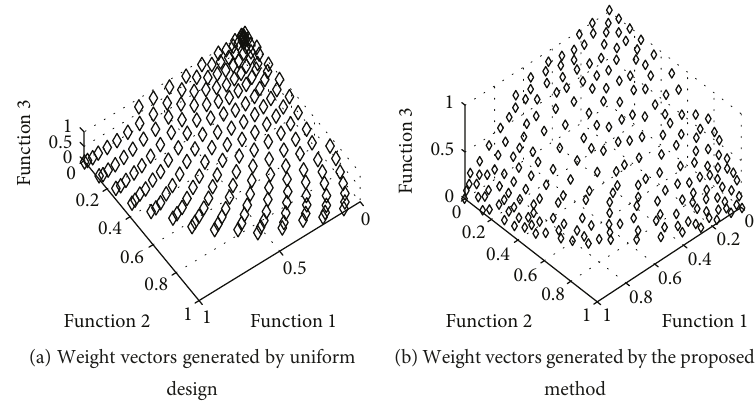
Figure 1: Uniformly distributed weight vectors generated by two